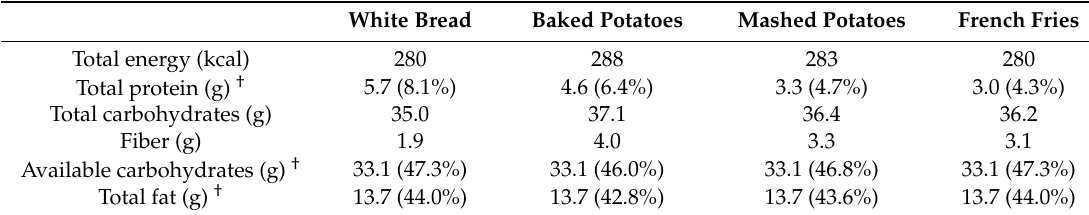
Table 1. Macronutrient composition of test treatments. White Bread Baked Potatoes Mashed